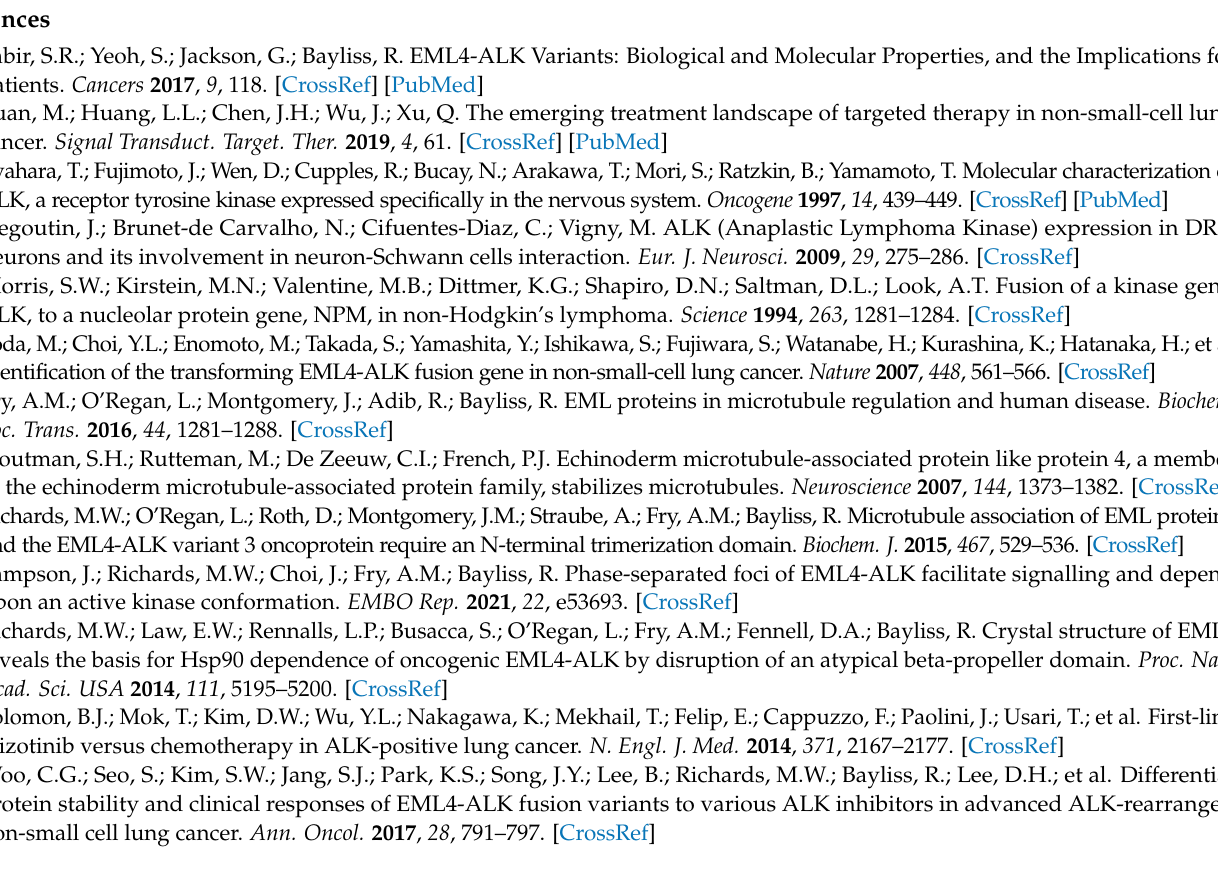
expression levels of apoptotic proteins upon vincristine and ceritinib treatments in H3122, but not in H2228. Figure S3: EML4-ALK V3 cells, but not V1, express high levels of acetylated tubulin upon vincristine treatment. Figure S4: Vincristine and ALK-TKIs inhibit signalling pathways in EML4- ALK-positive cells. Figure S5: Source data from Western blot Figure 4, Figure 5 and S2. Table S1: Compounds used and concentrations, Table S2: Antibodies used for immunofluorescence (IF) and western blotting (WB) and